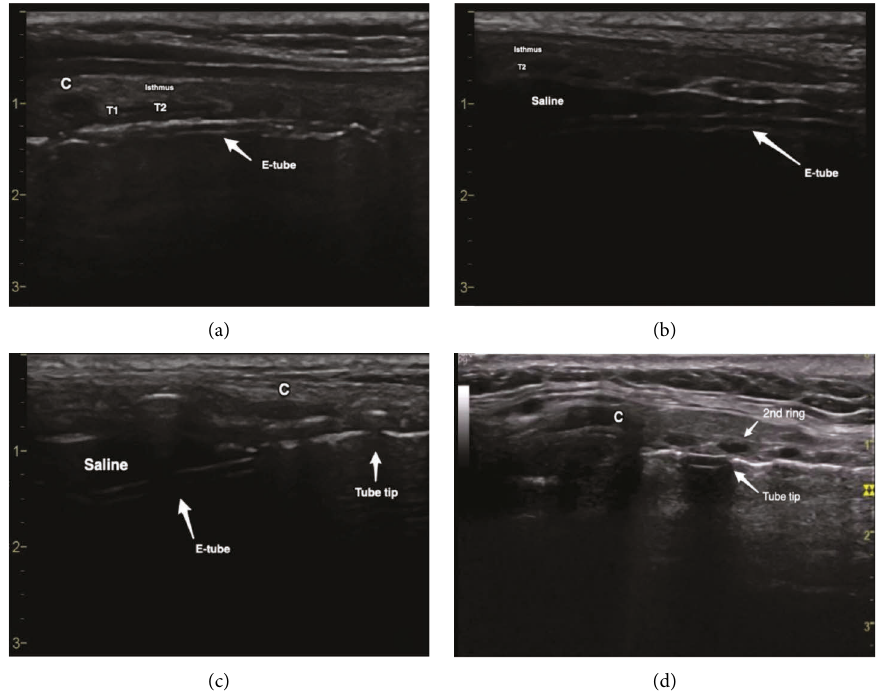
Figure 1: Endotracheal tube repositioning for percutaneous dilatational tracheostomy under ultrasound guidance. (a) Double-linear hyperechogenecity revealed the ET tube. (b) Anechoic filling and the ET tube were identified beneath the tracheal cartilage after saline ballooning. (c) Saline ballooning superior to the cricoid cartilage and pushing of the tracheal cartilage anteriorly by the ET tube tip were identified after pull back. (d) The ET tube tip was identified just superior to the 2nd tracheal ring in another patient. C: cricoid cartilage, ET tube: endotracheal tube, T1 and T2 : 1 st and 2 nd tracheal ring,